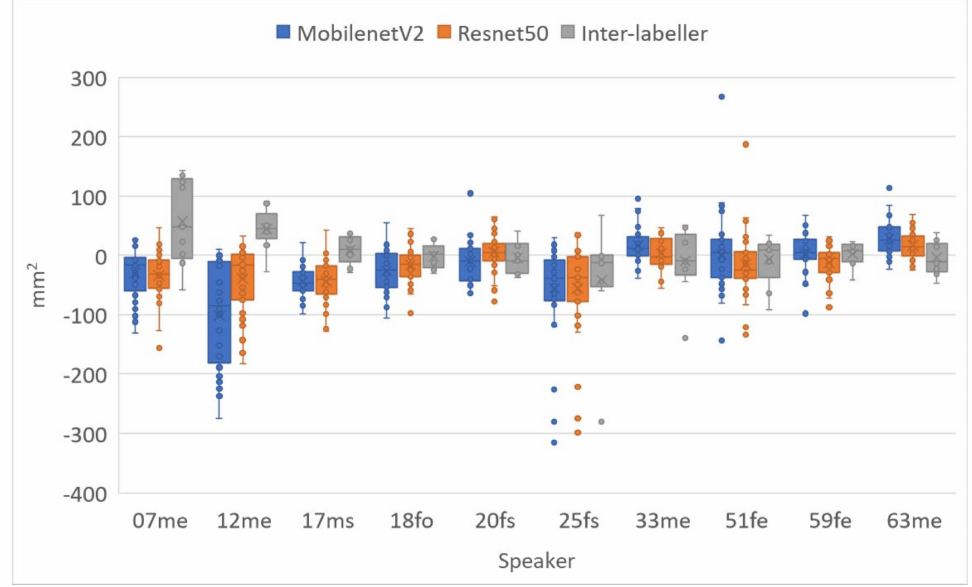
Figure 20. Difference in lip area between hand-labelled randomly selected frames (40 frames for each speaker) and DLC MobileNetV2_1.0, DLC ResNet50 and a second hand-labeller.